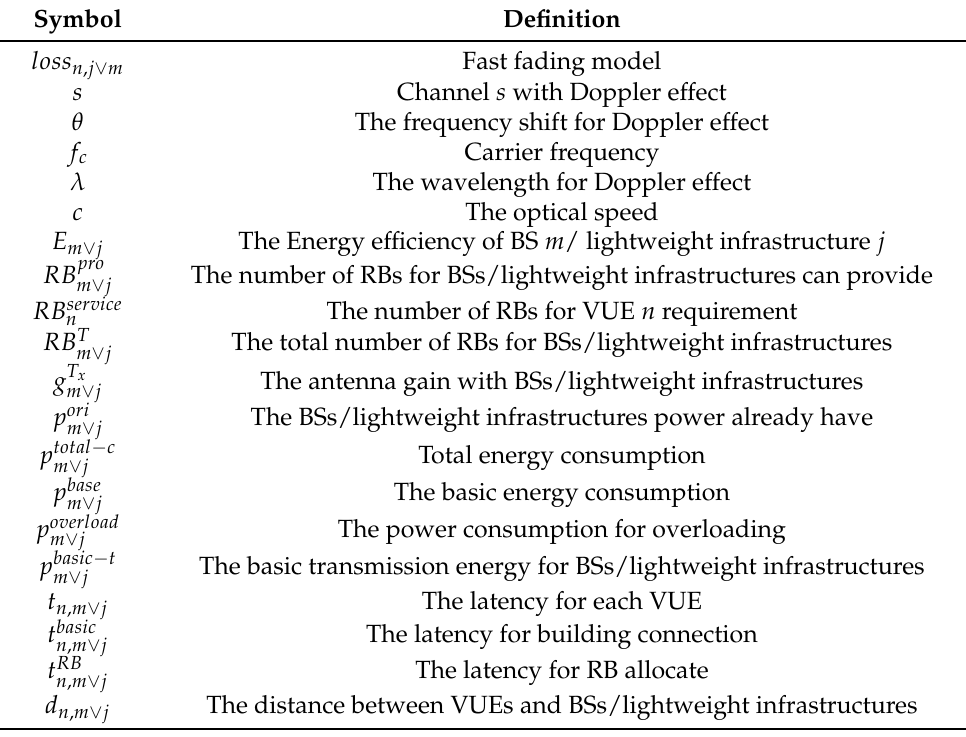
Table 2. The important symbols and definitions for this